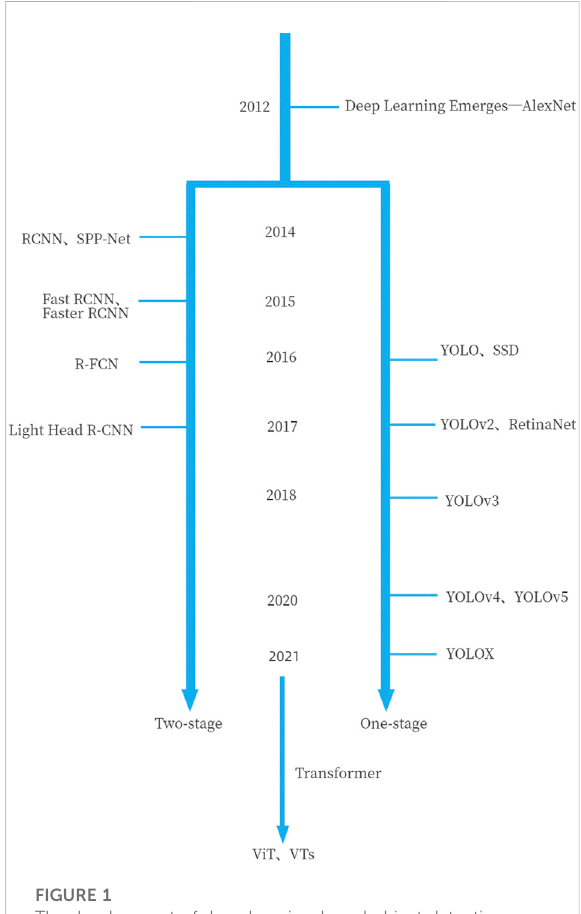
FIGURE 1 The development of deep learning-based object detection